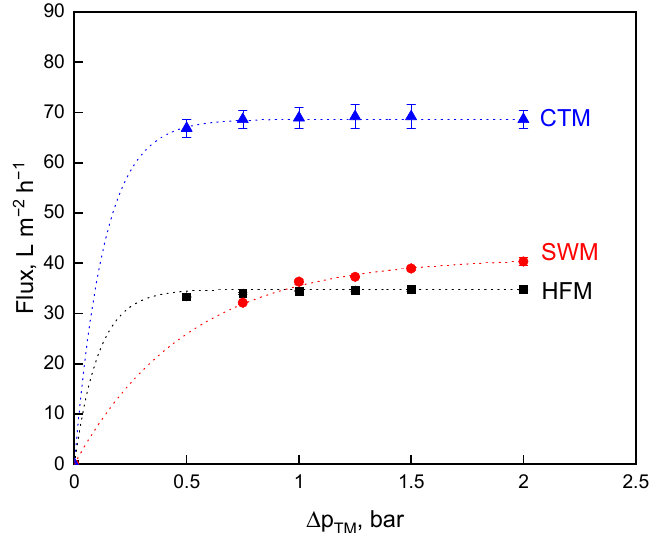
Figure 1. Flux as a function of the transmembrane pressure, ∆ p TM , for spiral wound membrane (SWM; • ), ceramic tubular membrane (CTM; ▲ ), and hollow fiber membrane (HFM; ■ ) at a feed (SWM; • ), ceramic tubular membrane (CTM; (cid:78) ), and hollow fiber membrane (HFM; (cid:4) ) at a feed . volume flow of 𝑉(cid:4662) = 20 m 3 ·h − 1 . V = 20 m 3 · h − 1 volume flow of